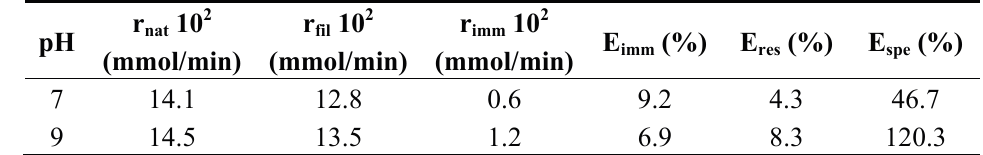
Table 4. Percentage of immobilized enzyme, E activity of the immobilized enzyme, E catalytic activity (mmol/min) of the native enzyme, r the immobilization process, r immobilized lipase on undemineralized sepiolite. The immobilization was carried out at pH 7 and